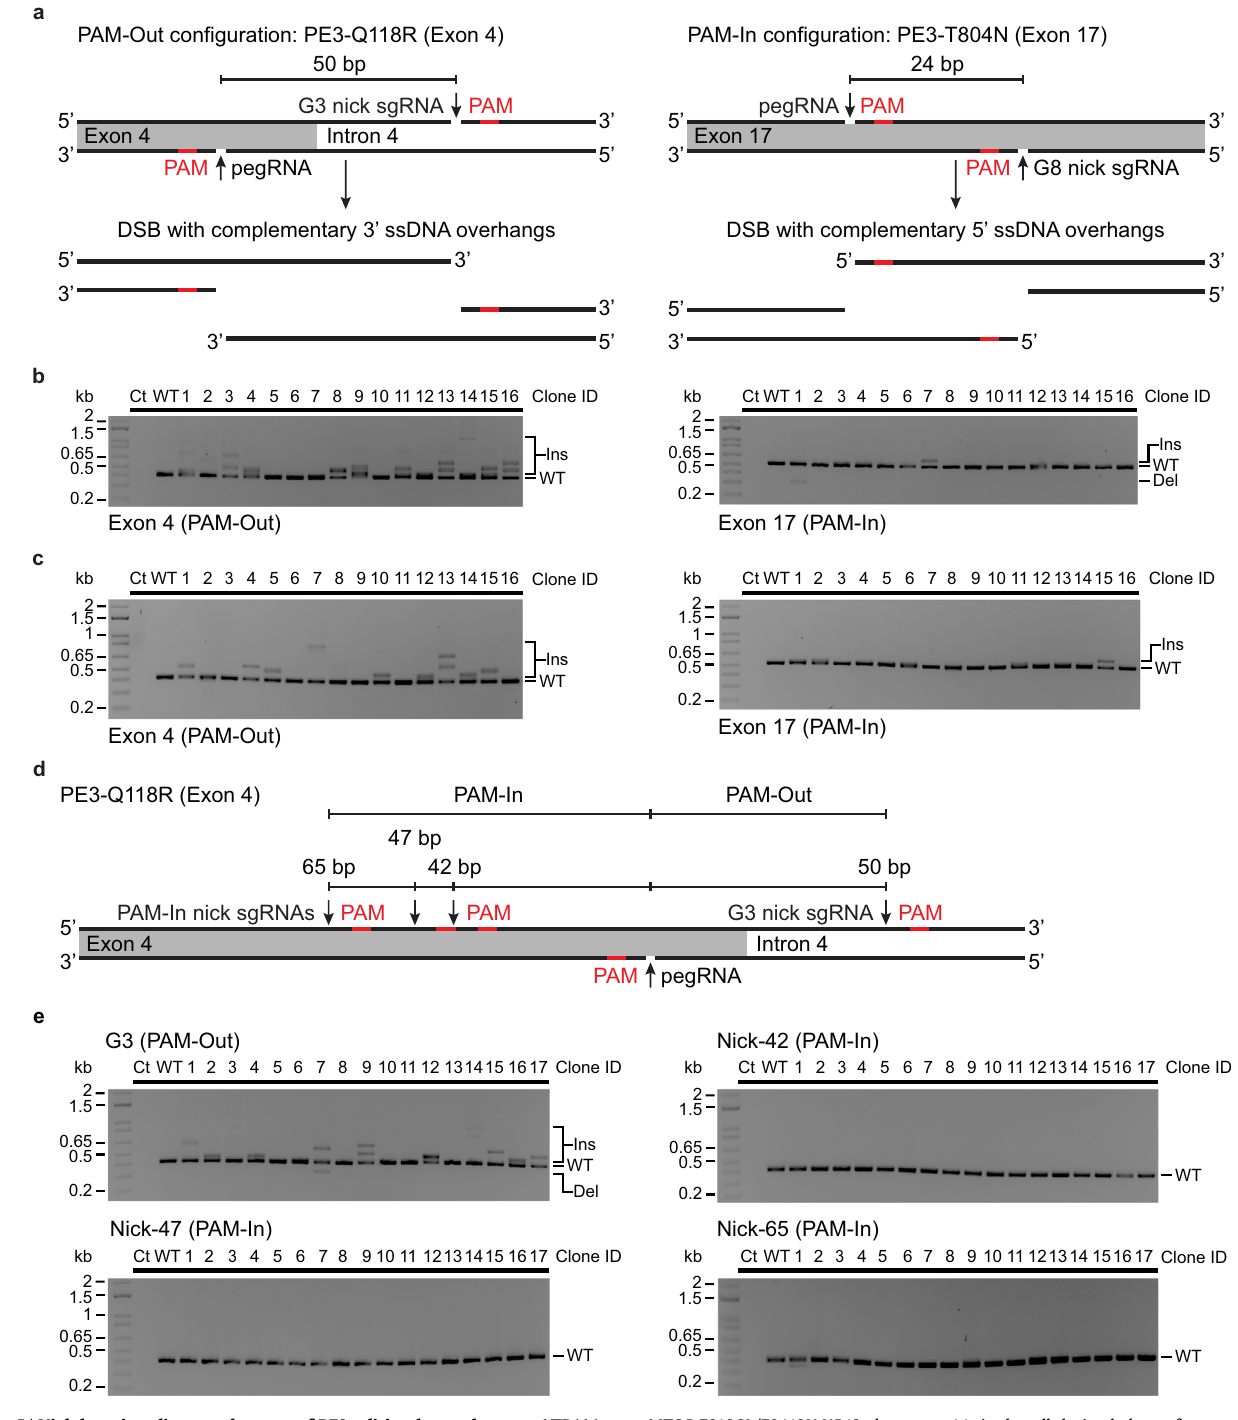
Fig. 5 | Nick location dictates the type of PE3 editing byproducts at ATP1A1 . a Schematic representation of the complementary 5 ′ and 3 ′ single-stranded DNA overhangs generated with the PE3-T804N strategy at ATP1A1 exon 17 (PAM-In con fi guration) and the PE3-Q118R strategy at ATP1A1 exon 4 (PAM-Out con fi gura- tion), respectively. b PCR-based genotyping of ATP1A1 exon 17 and 4 from single cell-derived MTOR -F2108L/I2017T K562 clones. Single cell-derived clones were isolated in methylcellulose-based semi-solid RPMI media supplemented with 100 µ M ouabain and genomic DNA was harvested after co-selection. n =16 single cell-derived clones from one experiment. c Same as in b with single cell-derived